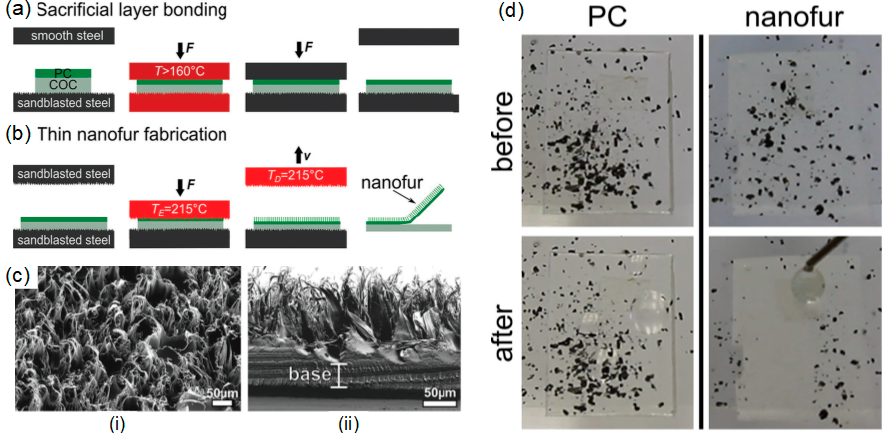
Figure 11. Bioinspired thin nanofur films mimic transparent hairs covering plant leaves. ( a , b ) Schematic of the fabrication process. PC and COC are bonded together in the hot embossing step. Softened PC fills the cavities of the finely sandblasted top mold pressed into the polymer. Retraction of the mold pulled out the softened PC, creating a crafted surface covered in a dense layer of nano- and micro hairs. The thin nanofur film is then separated from the sacrificial COC layer. ( c ) SEM images of the thin nanofur film: ( i ) top view and ( ii ) cross-section. ( d ) Self-cleaning of the superhydrophobic thin nanofur film (bottom) in comparison to the unstructured PC film (top). Left: graphite powder was distributed on both surfaces. Right: dispensed water droplets stuck to the unstructured PC film, but rolled down the thin nanofur film, picking up graphite particles and effectively cleaning the surface. Reproduced from [104] with permission; Copyright Wiley 2016.